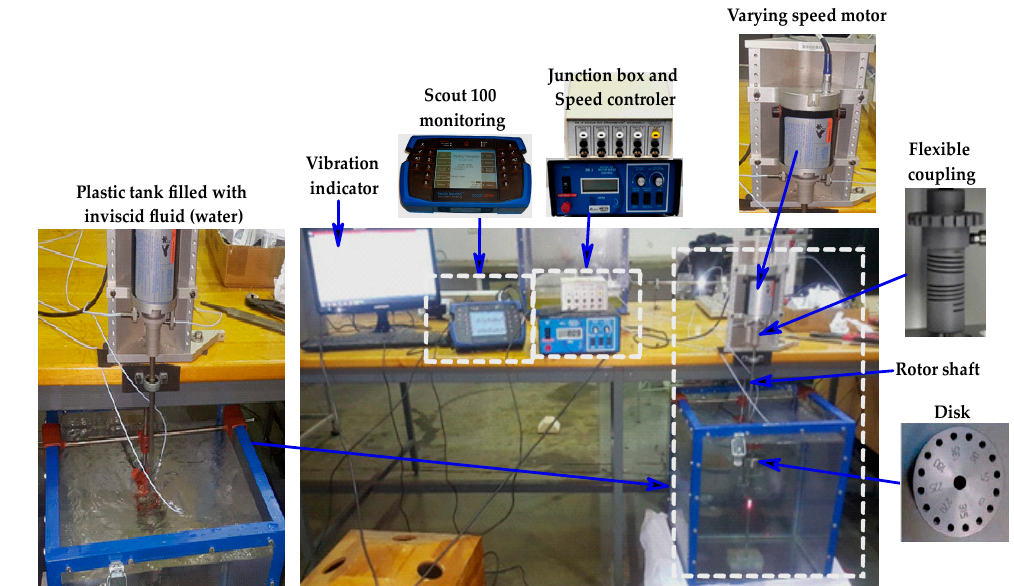
Figure 2. Laboratory setup of vertical rotating machinery system.